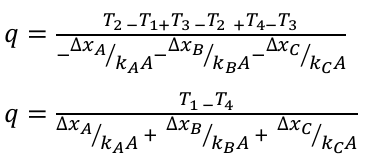
Changes of heat flux at different thicknesses of Silicon Carbide ∆𝒙 with fix thickness of solid carbon ( ∆𝑥 𝒄